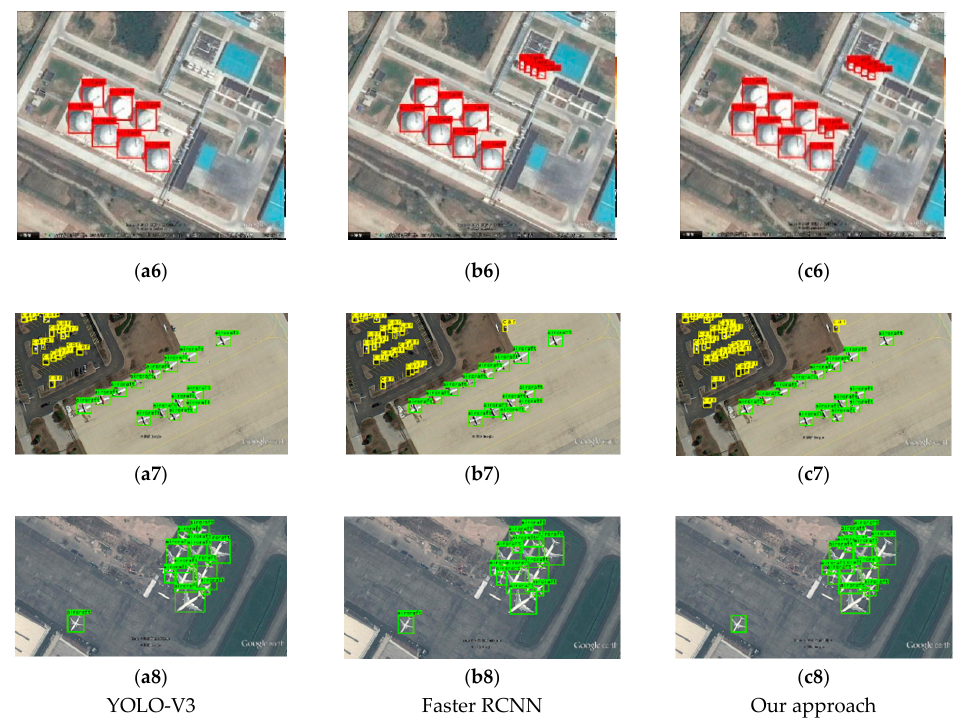
Figure 9. The comparison results of YOLO-V3 and our approach: ( a1 )–( a8 ) The detection results of YOLO-V3; ( b1 )–( b8 ) The detection results of Faster RCNN; ( c1 )–( c8 ) The detection results of our approach.